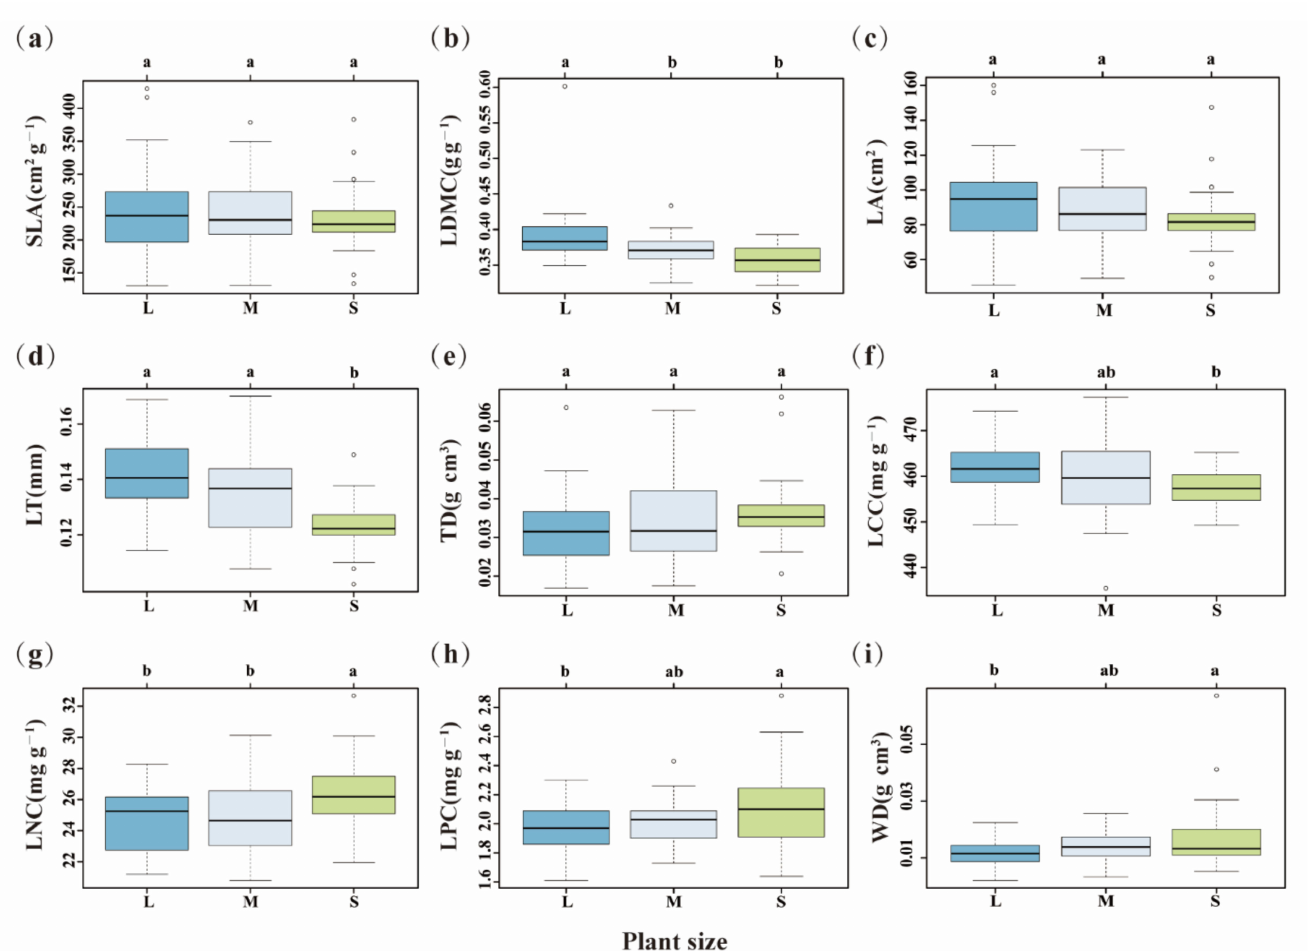
Figure 1. Differences in the functional traits ( a – i ) of Q. aliena var. acutiserrata among three plant sizes. Abbreviations of plant size: L (large tree); M (medium tree); S (small tree). Trait abbreviations: SLA (specific leaf area); LDMC (leaf dry matter content); LA (leaf area); LT (leaf thickness); TD (leaf tissue density); LCC (leaf carbon concentration per unit leaf mass); LNC (leaf nitrogen concentration per unit leaf mass); LPC (leaf phosphorus concentration per unit leaf mass); and WD (wood density). Table 3. Differences in the functional traits of Quercus aliena var. acutiserrata among six habitats.